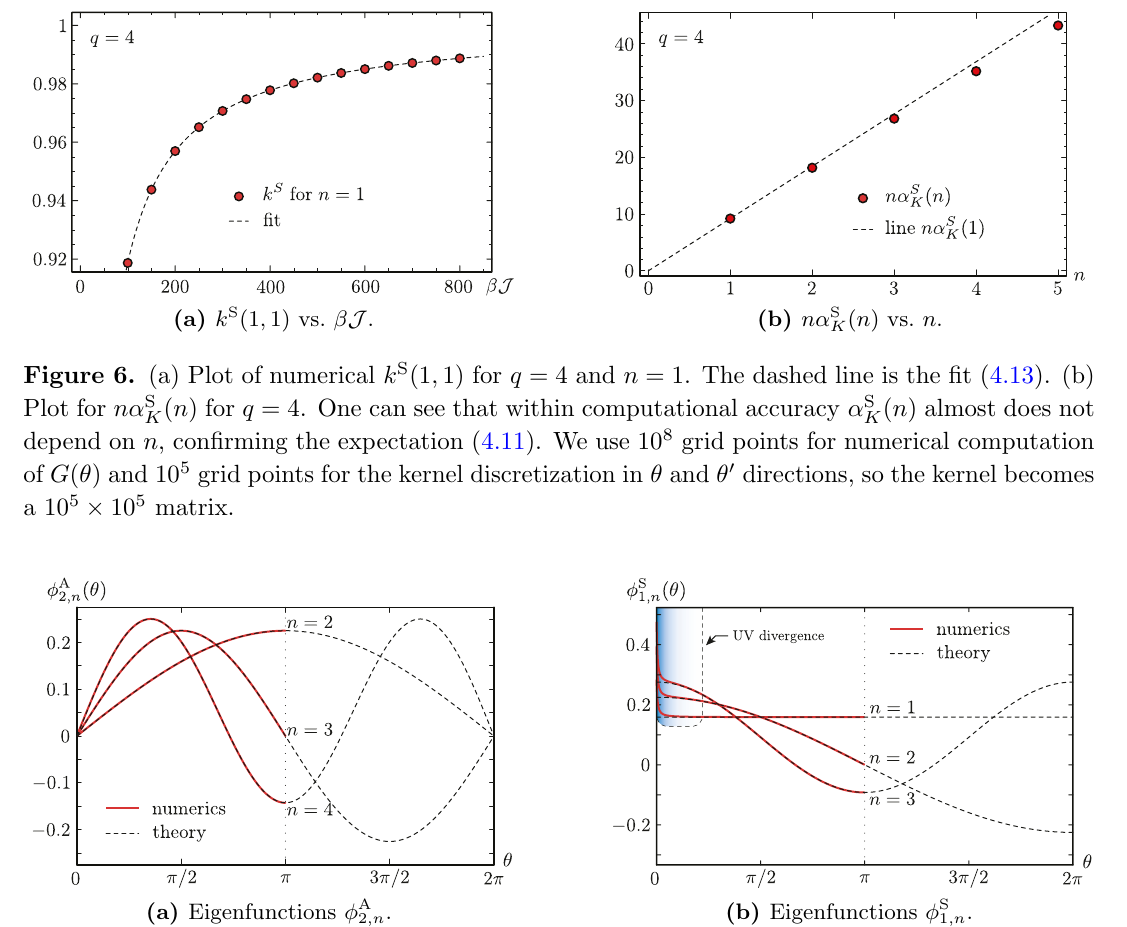
Figure 7. (a) numerical eigenfunctions (cid:30) A for the antisymmetric kernel; note the perfect agree- 2 ;n ment between numerics and the analytic solution. (b) numerical eigenfunctions (cid:30) S for the sym- 1 ;n metric kernel. In this case one can see UV divergence near (cid:18) = 0 where the numerics disagrees with the theoretical conformal perturbation